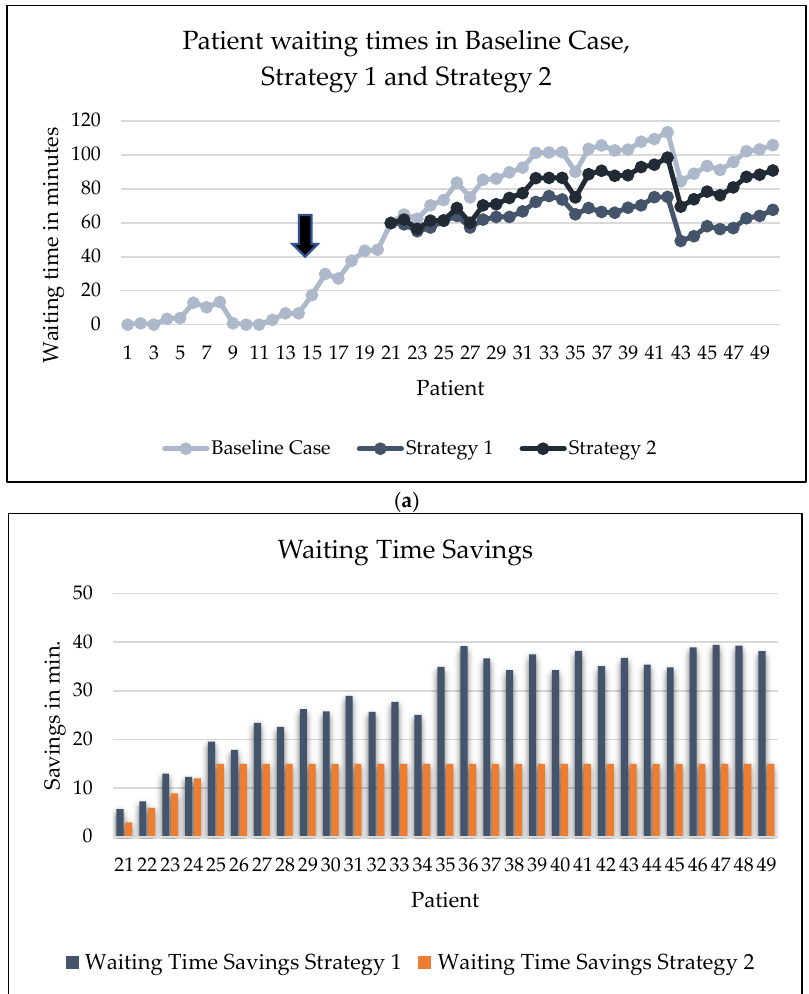
Figure 4. ( a ) Scenario 2 with an unforeseen long consultation time of an additional 15 min for patients 14 and 15 (see arrow). The light blue line shows the increase in waiting time if the treatment duration remains unchanged (Baseline). The mid-blue line shows the reduction in waiting times for Strategy 1 (reduction in consultation time to constantly 6 min), and the dark blue line shows the reduction in waiting times for Strategy 2 (reduction in consultation time by 3 min for the following five patients). ( b ) Waiting time savings for all subsequent patients when following Strategy 1 or Strategy 2 compared to the baseline case.